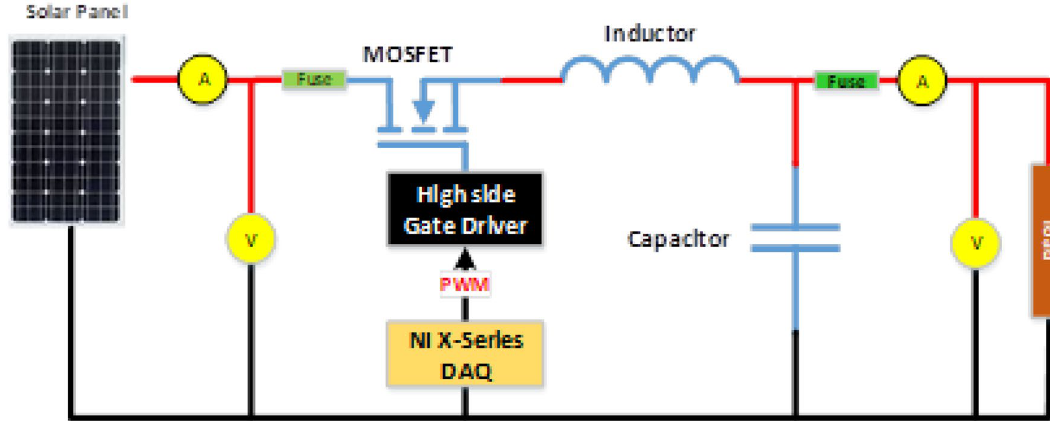
Figure 11. MOSFET switching circuit.